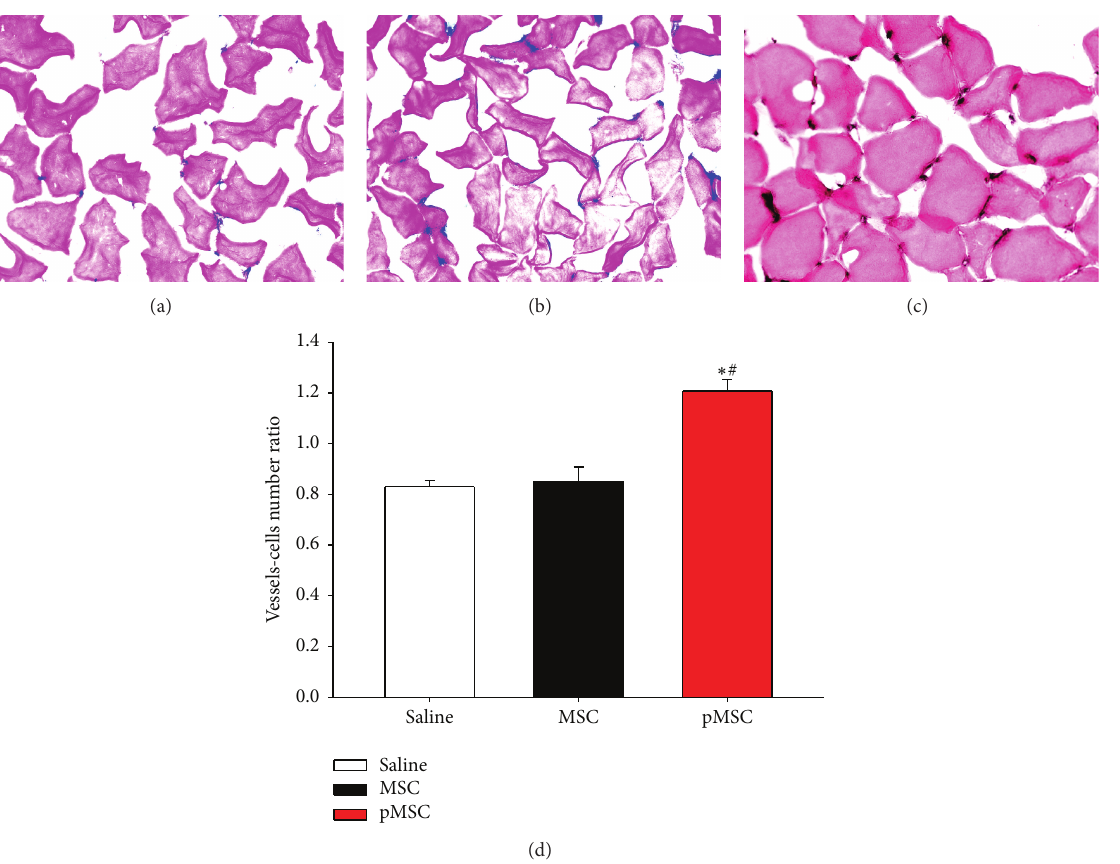
Figure 6: Microvascular density. Blue staining indicates capillaries. Photomicrographs obtained from animals from the saline (a), MSC (b), and pMSC (c) groups. Ratio between vessel number and the number of cells (d). Magnification: 400x. Values indicated as the mean ± sem. ∗ 𝑝 < 0.05 versus saline; # 𝑝 < 0.05 versus